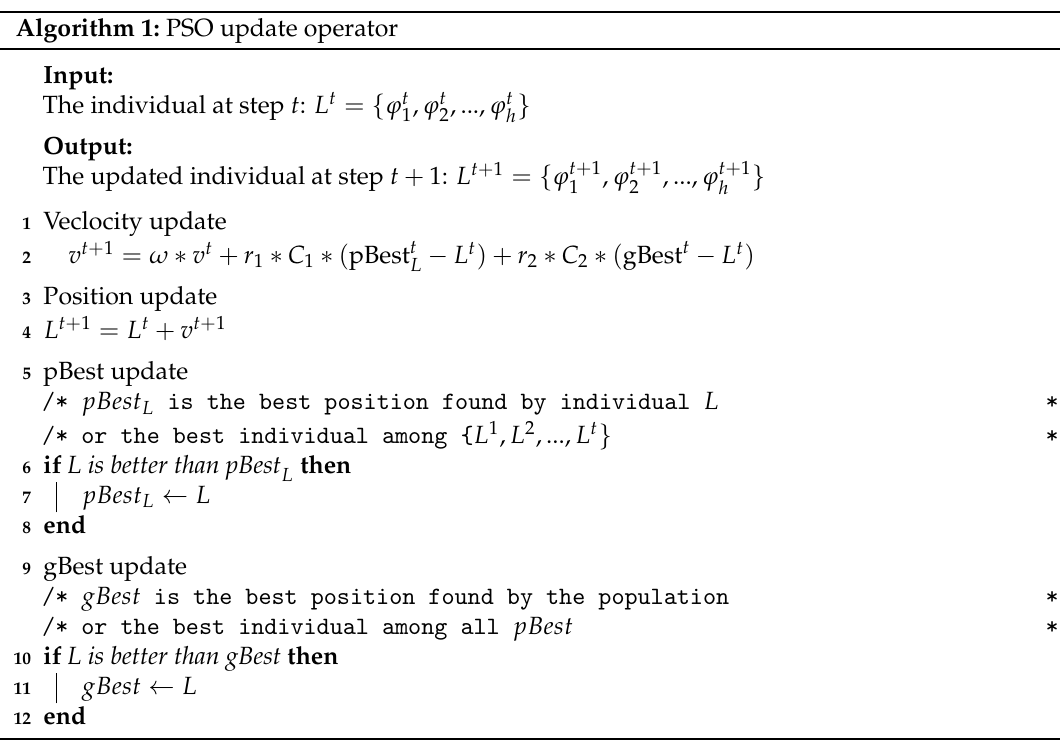
Algorithm 1: PSO update operator